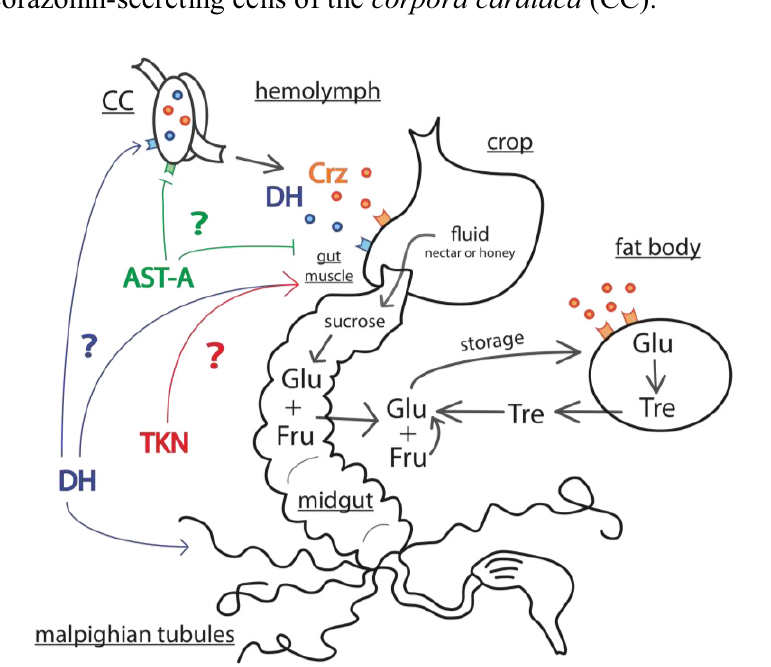
Figure 3. Hypothetical model of energy mobilization in honey bee . Glucose (Glu) and trehalose (Tre) are the main sources of energy in the hemolymph. Trehalose is stored in the fat body and, when necessary, is released into the hemolymph to be metabolized into glucose. Another source of hemolymph glucose is sucrose from nectar contained in the crop. If hemal carbohydrate levels drop, an influx of nectar is passed from the crop to the midgut via muscle contractions. In the midgut, sucrose is metabolized into fructose (Fru) and glucose, which are then transported to the hemolymph. The passage of nutrients from the crop to the midgut is allowed by contraction of the gut muscle, also named the proventriculus. During normal metabolic demands this influx from the crop depends on the carbohydrate concentration in the hemolymph [61,62]. In energy-demanding situations, this process might be boosted by tachykinin-related peptides (TRPs), diuretic hormone-I (DH-I), corazonin (Crz) and adipokinetic hormone (AKH) while an inhibitory effect from allatostatin A (AST-A) secreted from the midgut would be relieved. DH-I may also exert feedback on corazonin-secreting cells of the corpora cardiaca